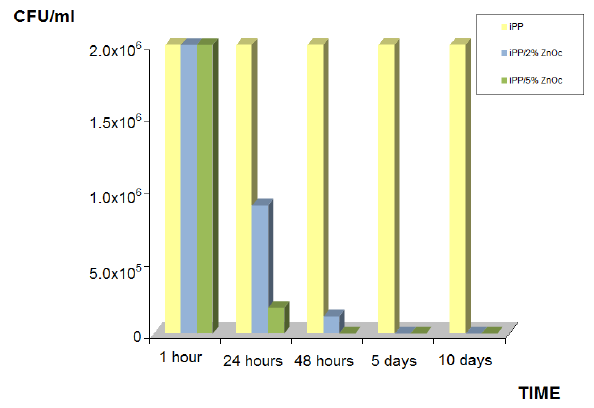
Figure 10. Effect of time and filler content on the antibacterial activity of iPP and iPP/2%–5% ZnOc composites. Table 5. Percent reduction of E.coli at different times of contact with films of iPP and iPP/2%–5% ZnOc. Sample